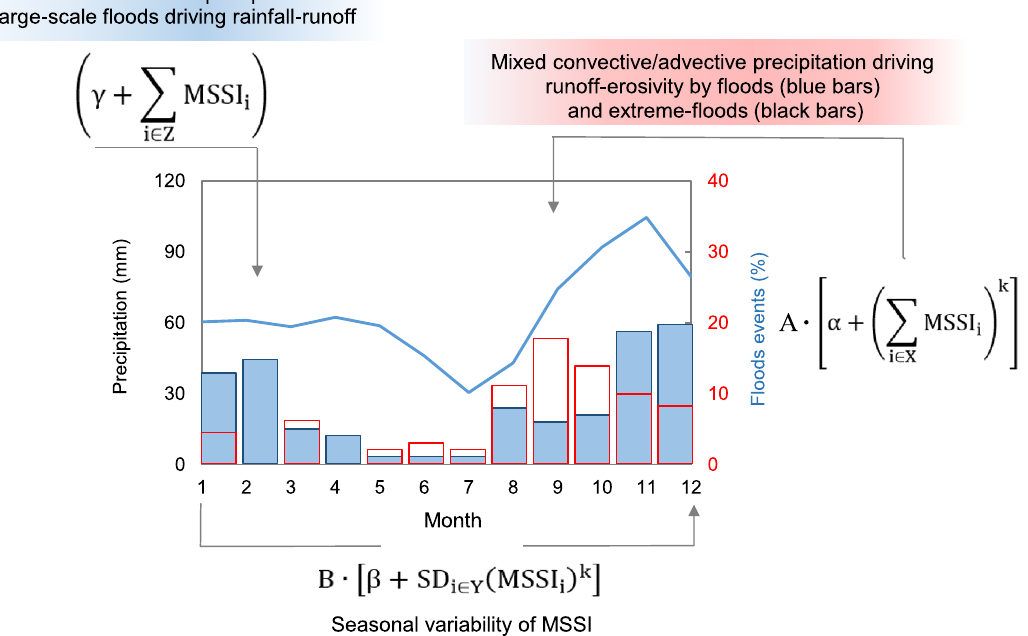
Figure 9. Monthly precipitation and frequency of floods and extreme floods (1940–2016) over the Tiber River Basin. Areal monthly rainfall totals (blue line) are from GPCC (Global Precipitation Climatology Centre) 0.25° by 0.25° monthly land-surface precipitation dataset 104 . Percentages of monthly floods (blue bars) and extreme floods (red-contoured bars) are from this study and ref. 32 , respectively. The terms of Eq. (5) are